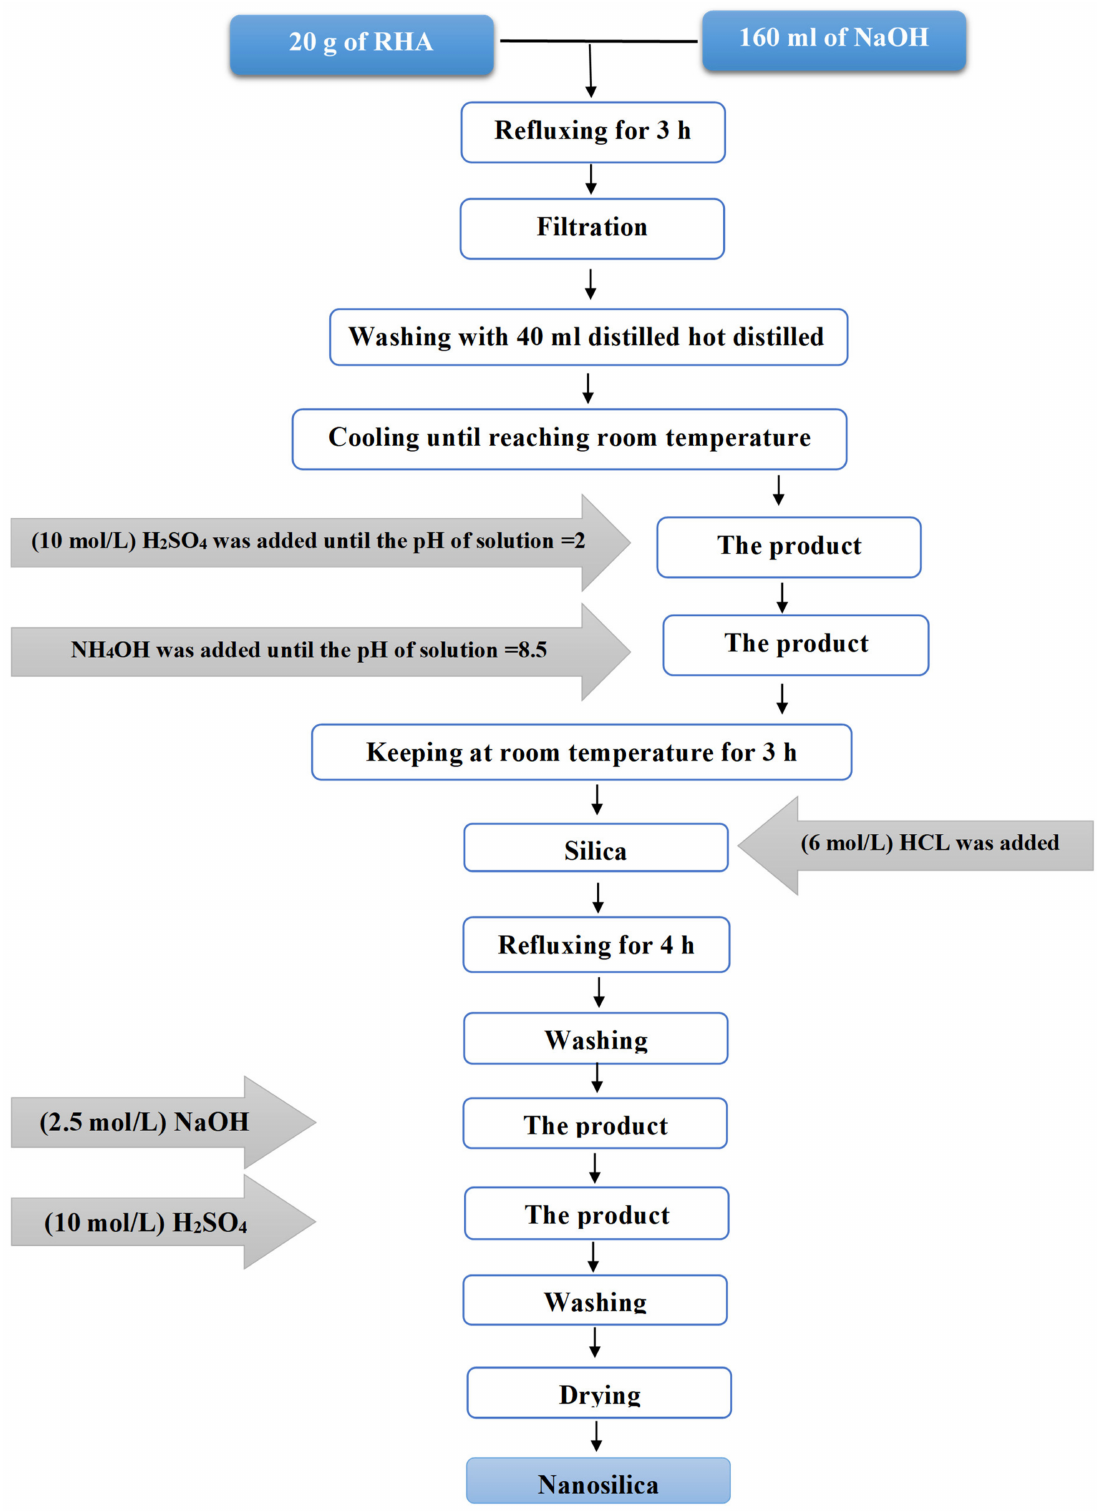
Figure 2. Block diagram of the preparation of nanosilica (NS) from rice husk